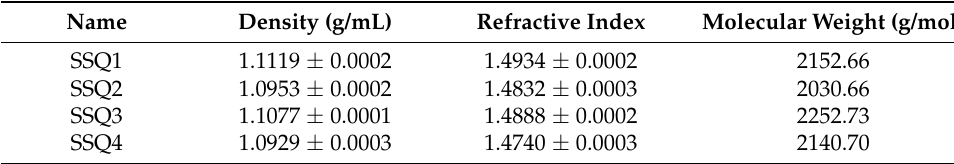
Table 3. Density, refractive index, and molecular weight of